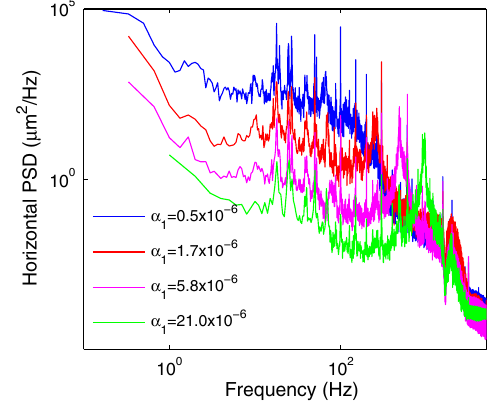
FIG. 13. Displacement PSD at a high dispersion BPM for several values of alpha.